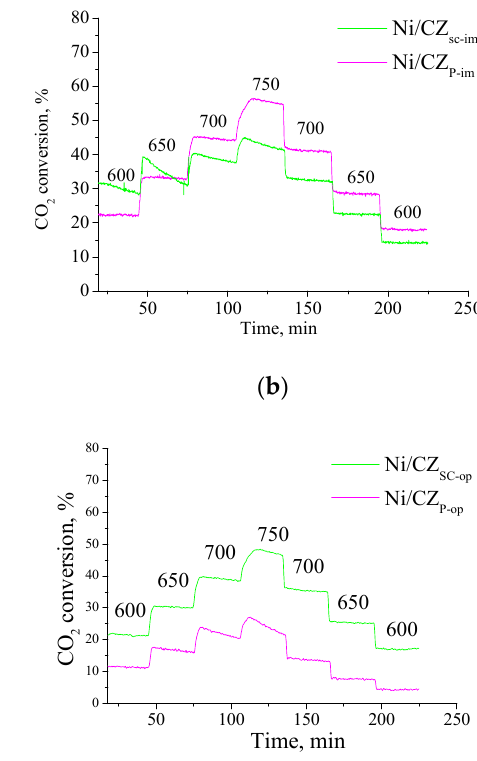
Figure 13. Methane and CO 2 conversions in thermal cycles 600–750–600 °C during dry reforming of CH 4 for impregnated ( a , b ) and one-pot ( c , d ) 5% Ni/Ce 0.75 Zr 0.25 O 2 catalysts prepared using the Pechini route and via supercritical synthesis.